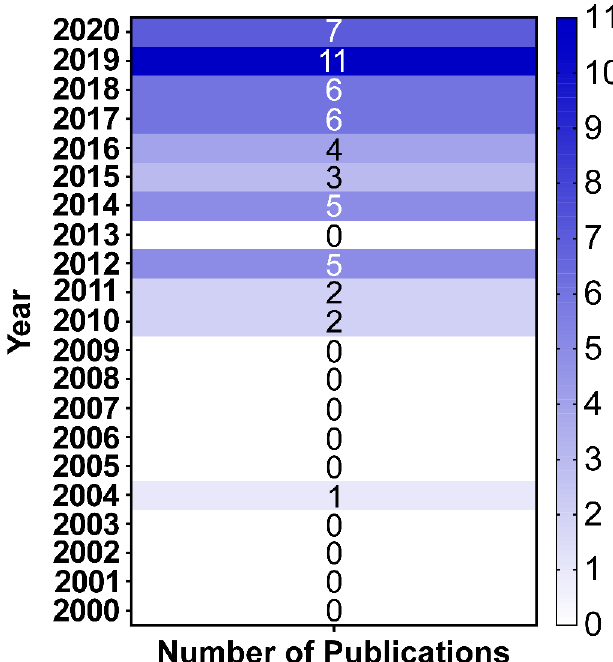
Figure 3. A heatmap of the distribution of the number of the publications about A. baumannii in LICs in the first 21 years of the 21st century. The heatmap was generated using GraphPad Prism v9 (GraphPad Software, San Diego, CA, USA).